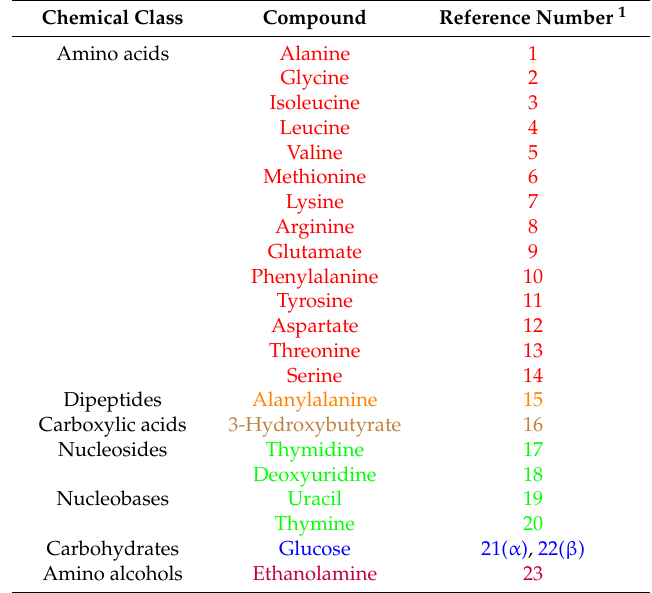
Figure 2. One-dimensional 13 C-spectrum for the seawater sample incubated over 2 days after the addition of 13 C 6 –glucose (Experiment 1). Patterns in the 13 C– 13 C coupling ( 1 J cc) for the major metabolites are shown as expanded panels. Italic numbers indicate the corresponding metabolites listed in Table 1. Greek letters in parentheses for amino acids denote the atom designation. For detailed analytical settings, see Table S1. In the panels showing the anomeric carbon of glucose (21 and 22), a spectrum determined for a standard compound of 13 C 6 –glucose is also shown (in brown), because the sample spectrum overlapped unknown signals (asterisks). Chemical structures were drawn by ACD/ChemSketch (ACD/Labs). Table 1. Summary of the metabolites assigned in this study using a combination of multiple pulse programs (see text for details). Metabolites were products of 13 C 6 –glucose transformed by a natural aquatic bacterial community during a 2-day incubation of a seawater sample collected from a coastal location (Experiment 1). Colors: amino acids: red; dipeptides: orange; carboxylic acids: brown; nucleosides and nucleobases: green; carbohydrates: blue; amino alcohols: